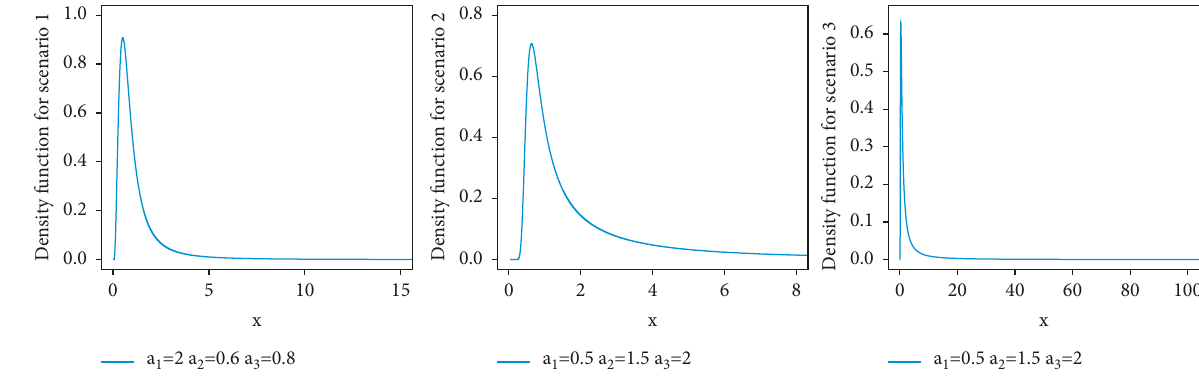
Figure 2: Density functions for three